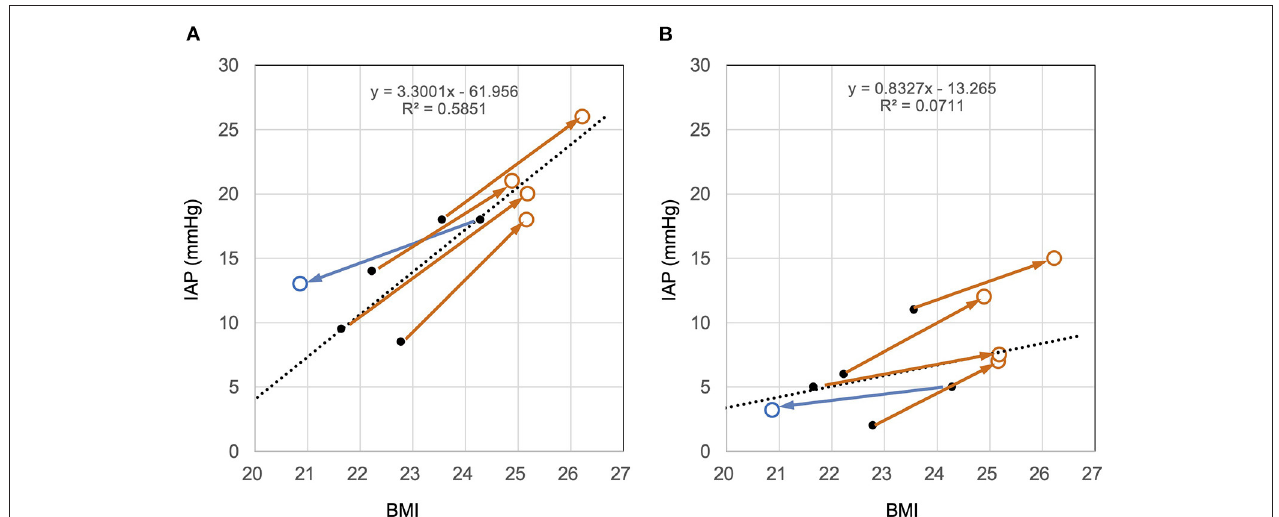
FIGURE 6 | Cross-sectional and longitudinal relationship between BMI and IAP in the sitting (A) and supine (B) positions. The black dots and dotted lines represent the relationship between the BMI and IAP immediately after surgery and their regression lines, respectively. Brown open circles represent the time point at which the patient gained weight. Blue open circles represent the time of weight loss. (A) In the sitting position, IAP immediately after surgery was positively correlated with BMI (dots). The change with weight change is shown as a vector. The slope of the vector and the regression line is similar. This finding indicates that the IAP change with weight change follows the correlation between BMI and IAP. (B) The same trend was observed in the supine position as in the sitting position. Judging from the slope of the vectors, the effect of BMI on IAP in the supine position was about half that in the sitting position.